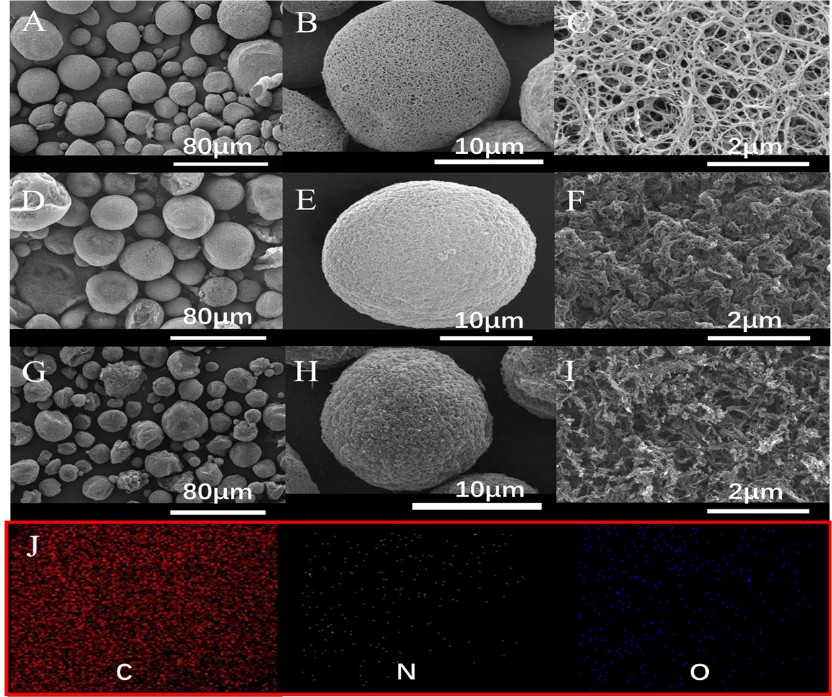
Figure 1. SEM images of FM-chitin ( A – C ), N-doped CM-chitin before ( D – F ) and after ( G – I ) adsorption of CR, and elemental mappings ( J ) of C, N, and O of N-doped CM-chitin.